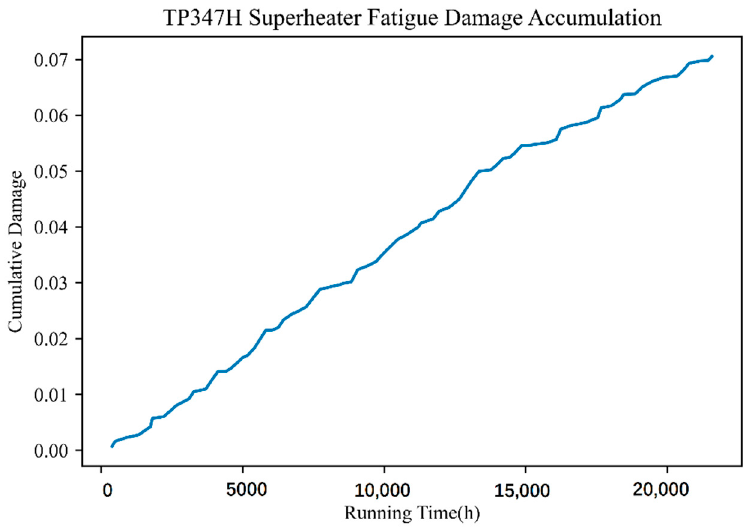
Figure 9. Relationship between service time and fatigue damage of the TP347H material of the final superheater.